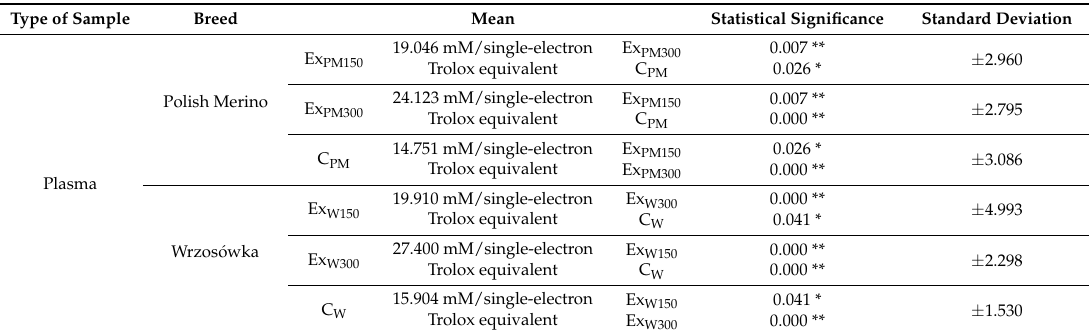
Table 7. Non-enzymatic total antioxidant capacity (mM/single-electron Trolox equivalent) in serum and liver as affected by the dose of the